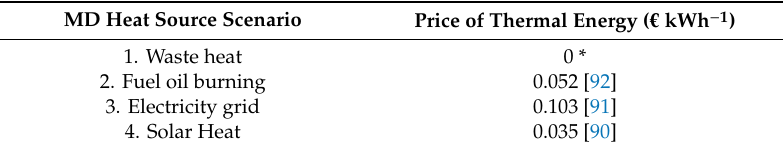
Table 3. Thermal energy prices according to the proposed heat